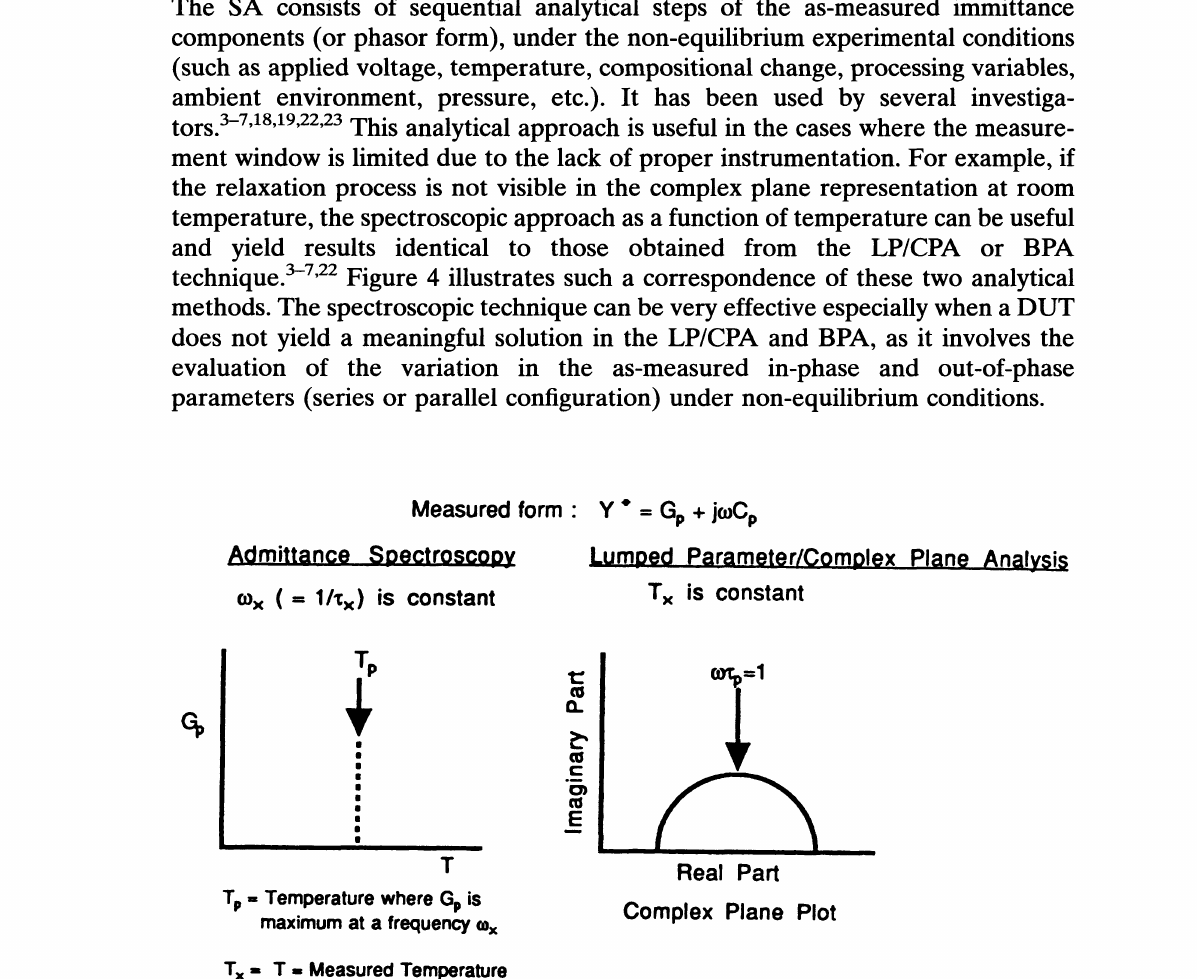
FIGURE 4 Demonstration of identical results obtained via lumped parameter/complex plane analysis (LP/CPA) and spectroscopic analysis (SA)